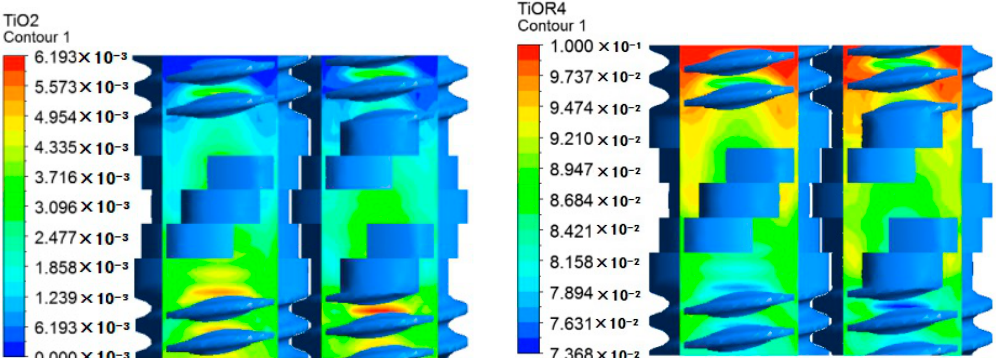
Figure 6. Concentrations of reactant and product at plane A.